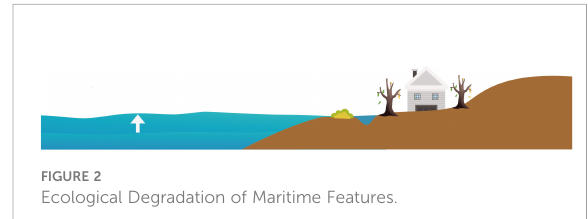
FIGURE 2 Ecological Degradation of Maritime